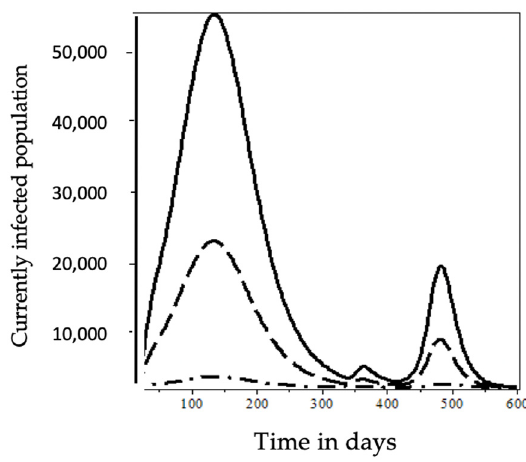
Figure 8. Model prediction of the current active cases in the Saudi Arabia: continuous line ( Y ( t )) , dashed line ( N ( t )) , and dashed/dotted line ( H ( t ))